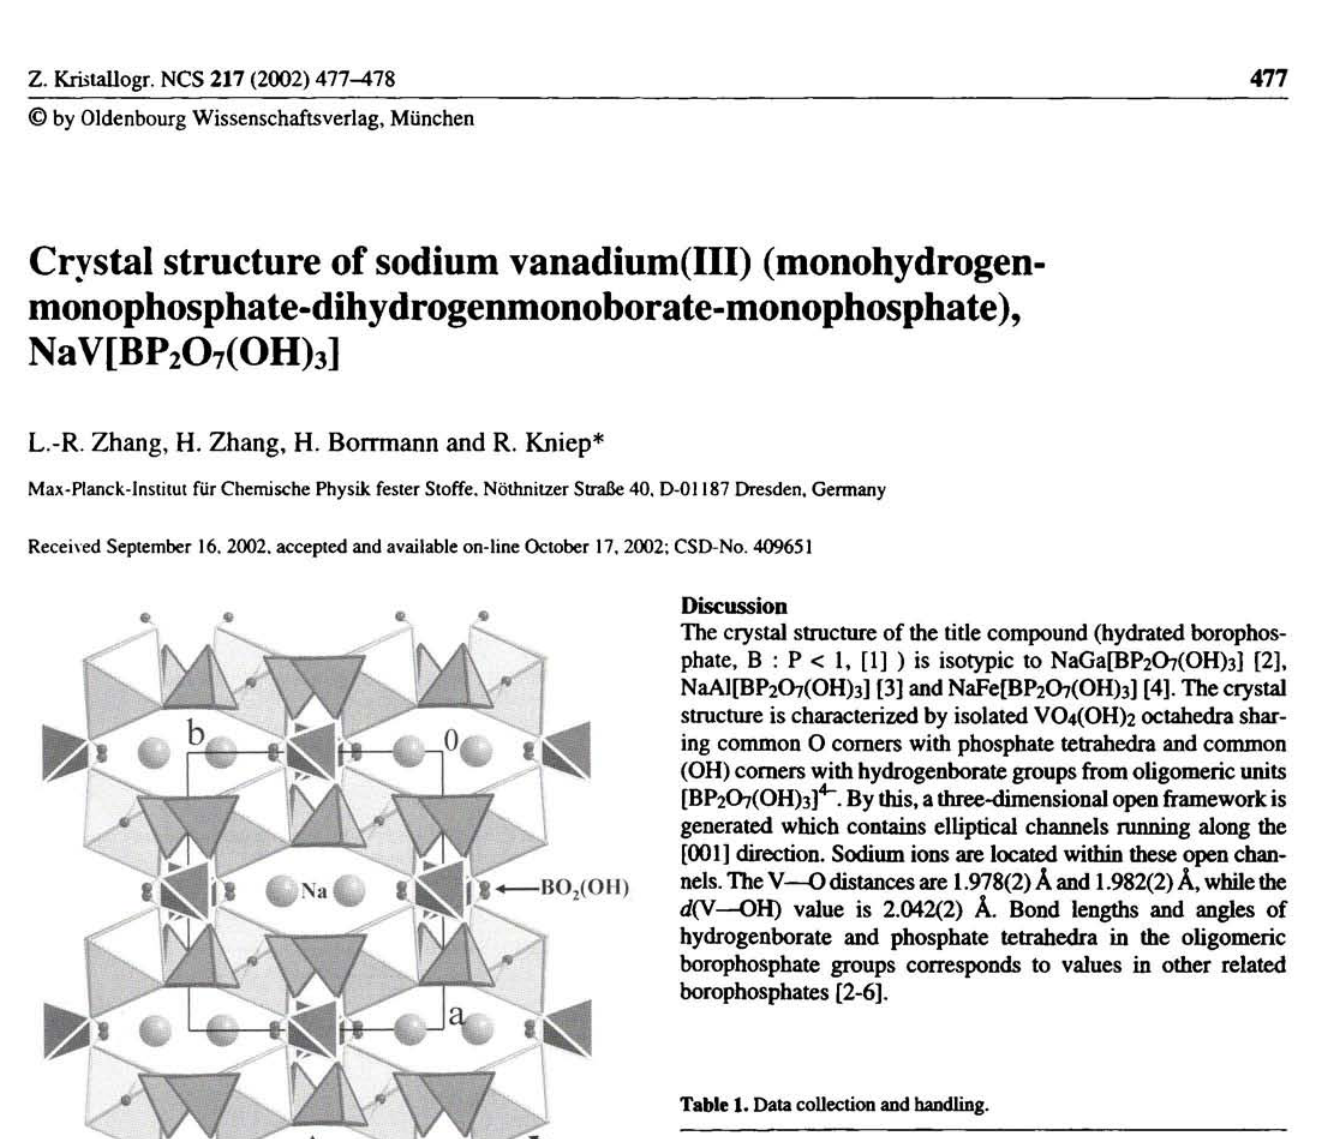
Table 1. Data collection and handling.